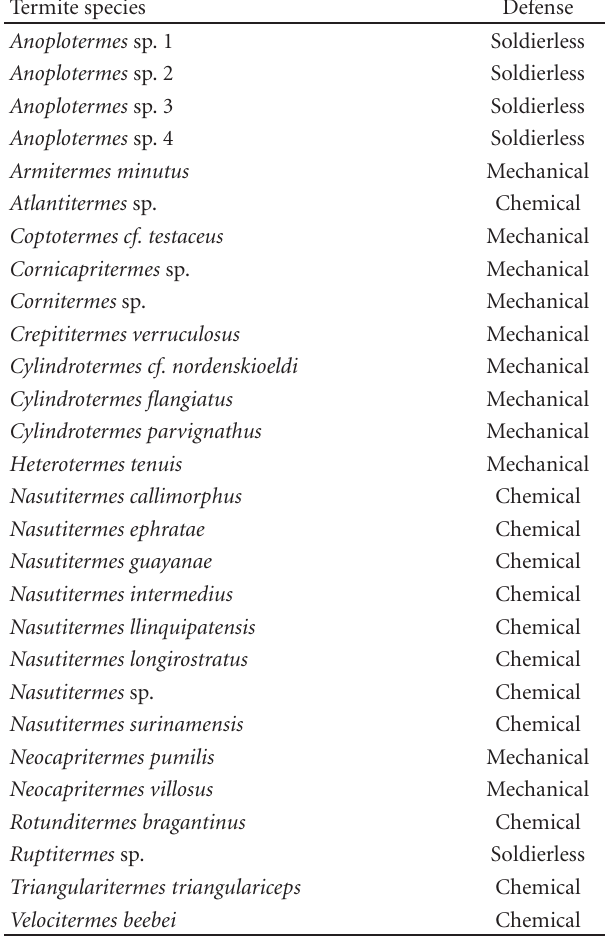
Table 1: List of termite species collected at TBS, and their category of soldier defensive